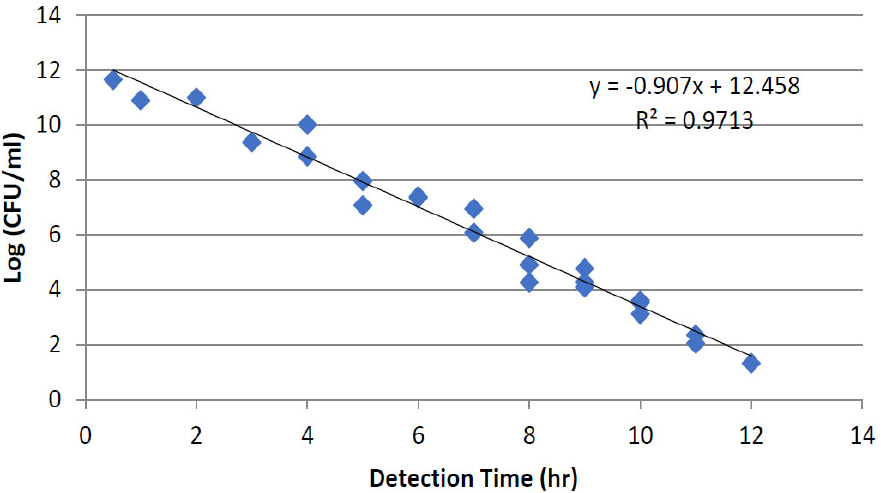
Figure 4. Calibration of BacTrac equipment for Escherichia coli enumeration in the diluted protein shake